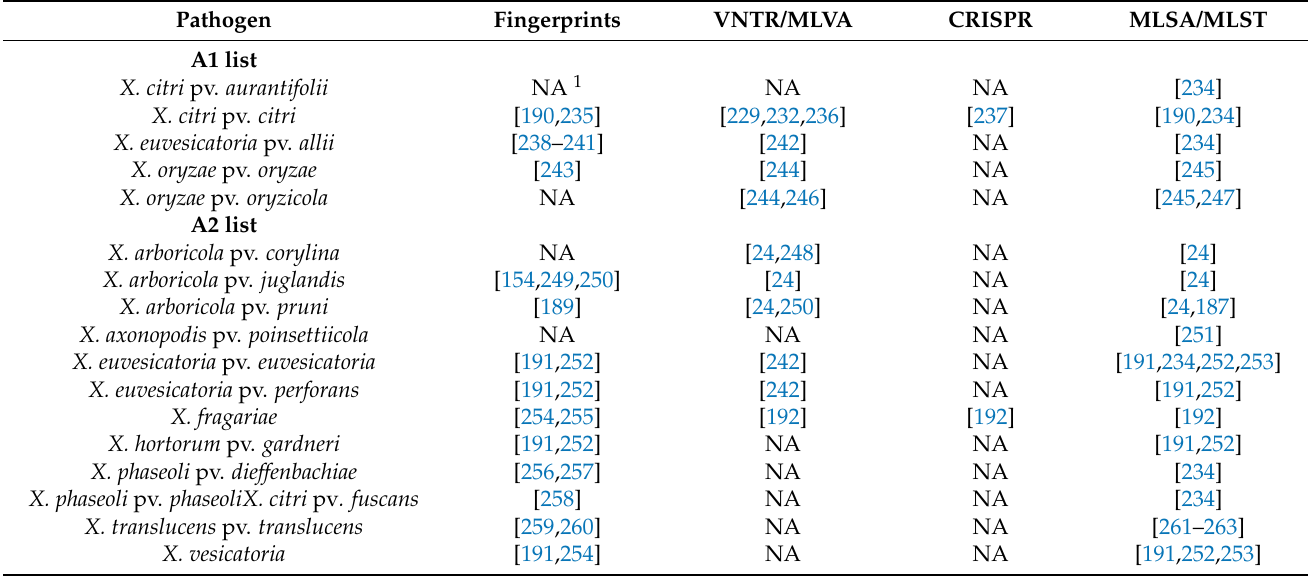
Table 3. Tools for molecular typing of regulated Xanthomonas